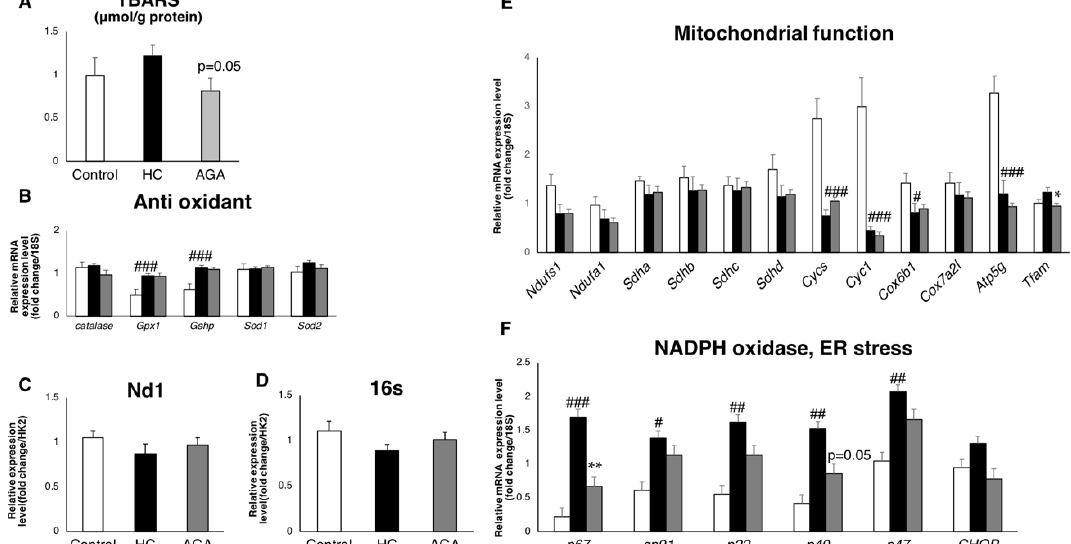
Figure 4. Agaricus brasiliensis KA21 (AGA) reduces oxidative stress in the liver. Control diet (Control), high-fat and high-cholesterol diet (HC), and high-fat and high-cholesterol + 5% AGA. ( A ) Lipid peroxide; ( B ) expression of an antioxidant enzyme in the liver; ( C ) mitochondrial copy number (Nd1) in the liver; ( D ) mitochondrial copy number (16S) in the liver; ( E ) gene expression for the mitochondrial complex in the liver ( n = 7), normalized by using 18S rRNA; (F) gene expression for nicotinamide adenine dinucleotide phosphate (NADPH) (free radical source) activity in the liver ( n = 7), normalized by using 18S rRNA. Data are presented as the mean ± SEM values. n = 7 mice per group. Statistical analysis was performed by one-way ANOVA, followed by Bonferroni’s post-hoc test. # / * p < 0.05; ## /** p < 0.01, ### p < 0.001 versus mice in the HC group ( # significant differences for HC versus Control, * significant differences for HC versus AGA).